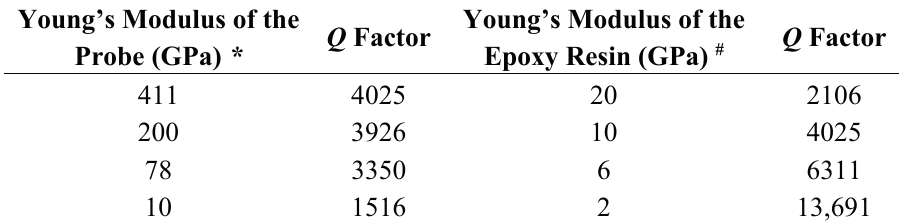
Table 5. The impact of the Young’s modulus on the Q